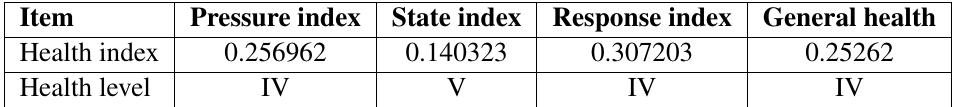
Table 10 Ecosystem health index and level of the